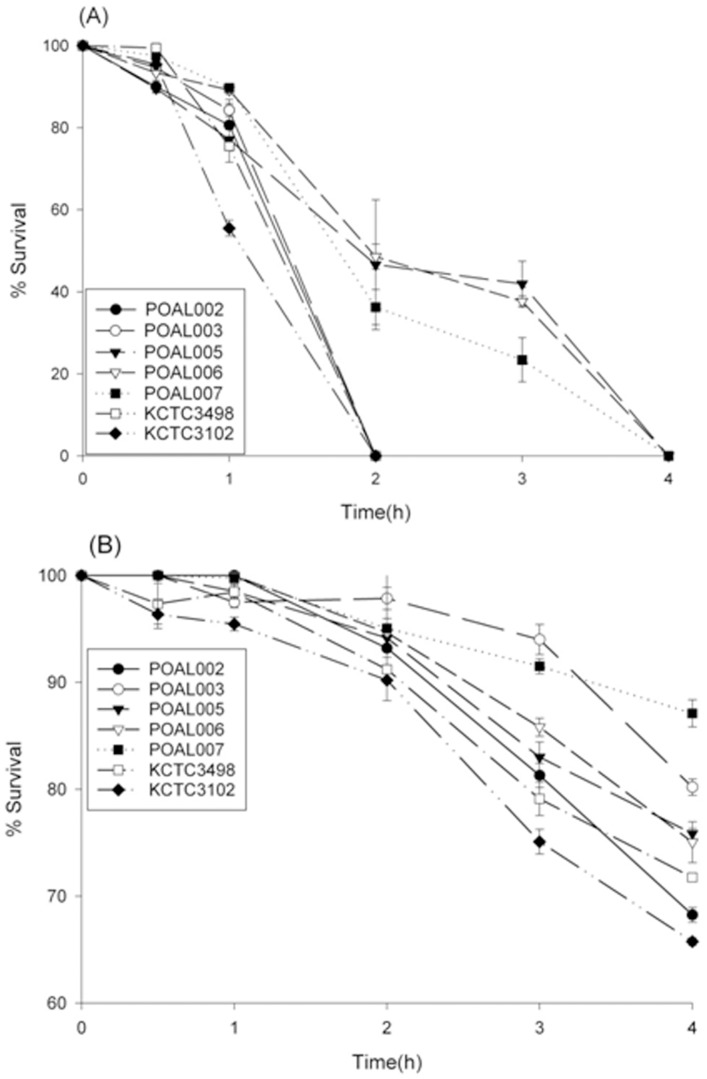
Survival of L. brevis POAL strains at pH 2.5 (A) and pH 3.0 (B), respectively.